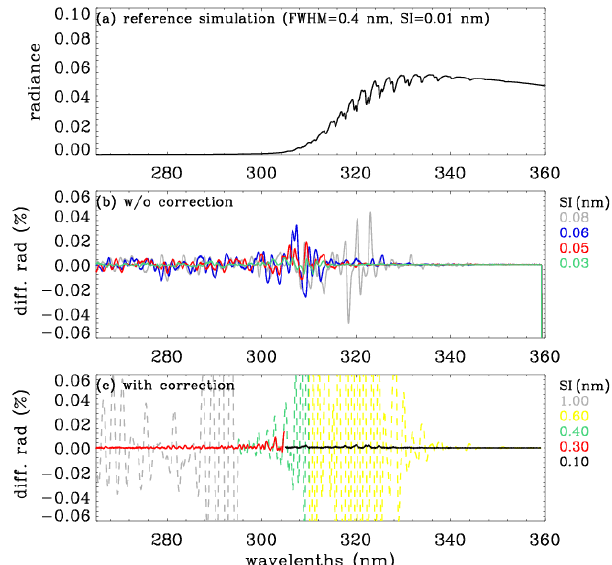
Figure 2. (a) Reference (truth) normalized radiance spectrum simu- lated at the spectral intervals (SIs) of 0.01nm in 265–360nm (solar zenith angle, SZA = 65 ◦ ; viewing zenith angle, VZA = 30 ◦ ; rela- tive azimuth angle, AZA = 120 ◦ ), which is used for evaluating the simulations in panels (b) and (c) . (b) Impact of undersampling on the simulation. Panel (c) is similar to panel (b) , but now the un- dersampling correction has been applied; the dashed and solid lines represent the sampling rates for v1 and v2, respectively. Note that individual radiances simulated at different SIs are interpolated to 0.01nm and then convolved with the Gaussian function (FWHM: 0.4nm) which represents the OMI instrument spectral response